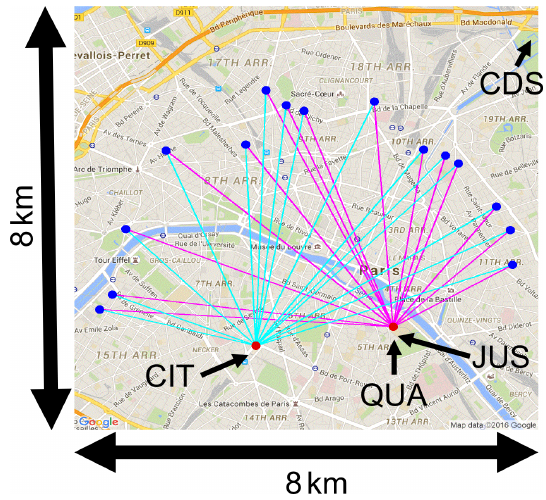
Figure 1. Example GreenLITE ™ system layout in Paris, France. The red dots in the images denote the transceiver locations (CIT and JUS), and the blue dots indicate the placement of 15 retroreflec- tors. The cyan and magenta lines depict the lines of sight between each transceiver and the retroreflectors. The locations of the two in situ stations are also indicated by the two black arrows, Cite des Sciences et de l’Industrie (CDS) and QUALAIR laboratory (QUA). QUA is located in close proximity to JUS on the same campus.